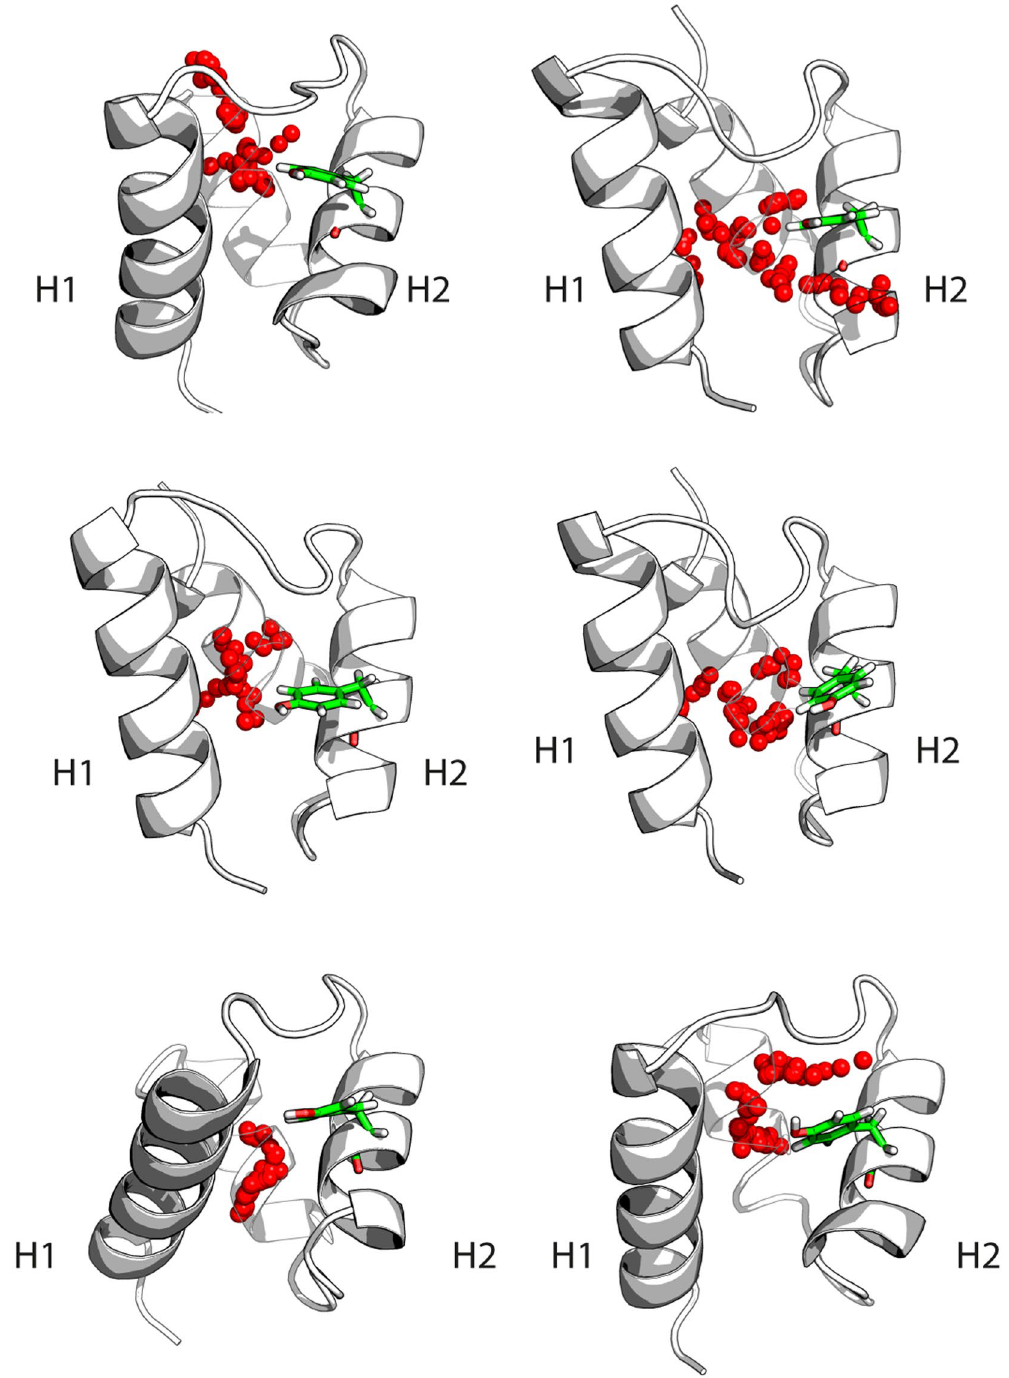
Figure 5. Computational pocket identification in conformers generated by molecular dynamics of NPM mutant E C-terminal domain. MD generated conformers with the top scoring pockets as assessed by fpocket druggability score are shown (pocket #2 only). Each panel shows a MD conformer in cartoon representation with the predicted pocket shown in red spheres. Tyr271 is depicted in sticks representation